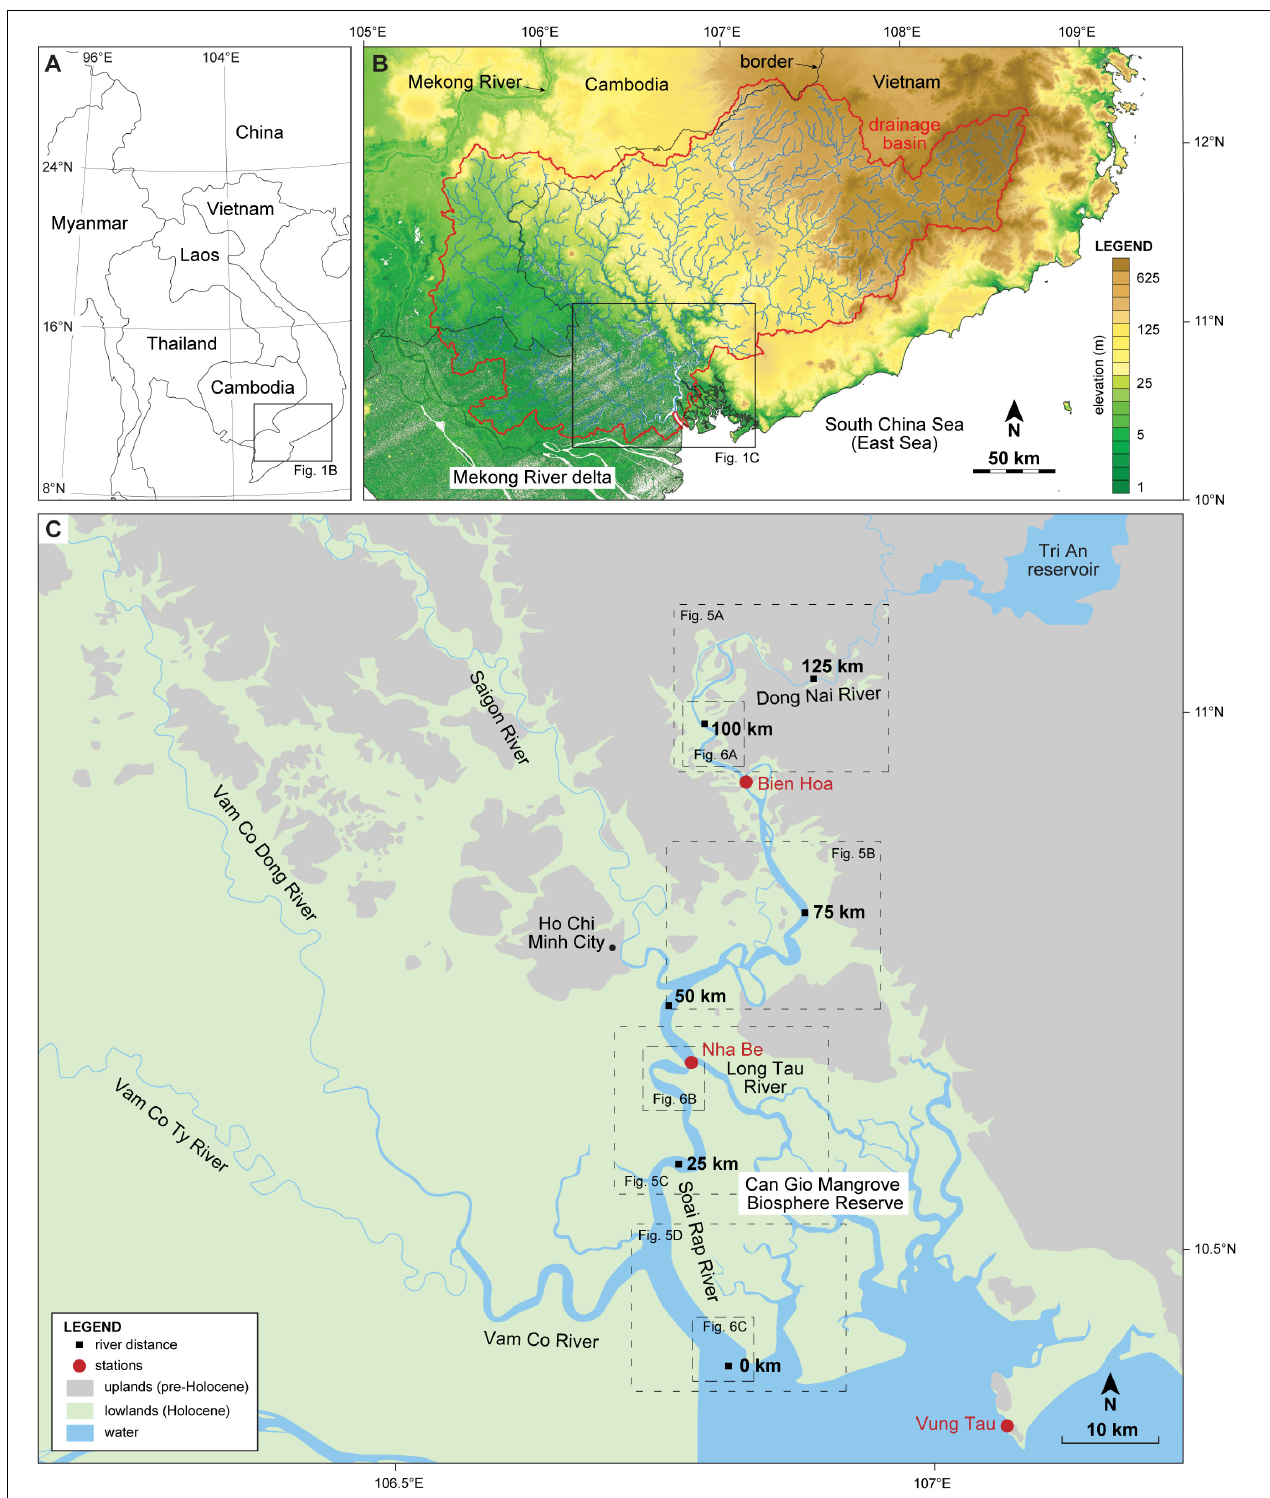
FIGURE 1 | (A) Map of Southeast Asia with location of the DNRS in southern Vietnam. (B) DEM of the DNRS drainage basin and surrounding areas. (C) Map of the DNRS with distribution of pre-Holocene uplands and Holocene lowlands, indication of river distance along the Ð`ông Nai–Soài Ra.p River, and locations of the climate and water-level stations.